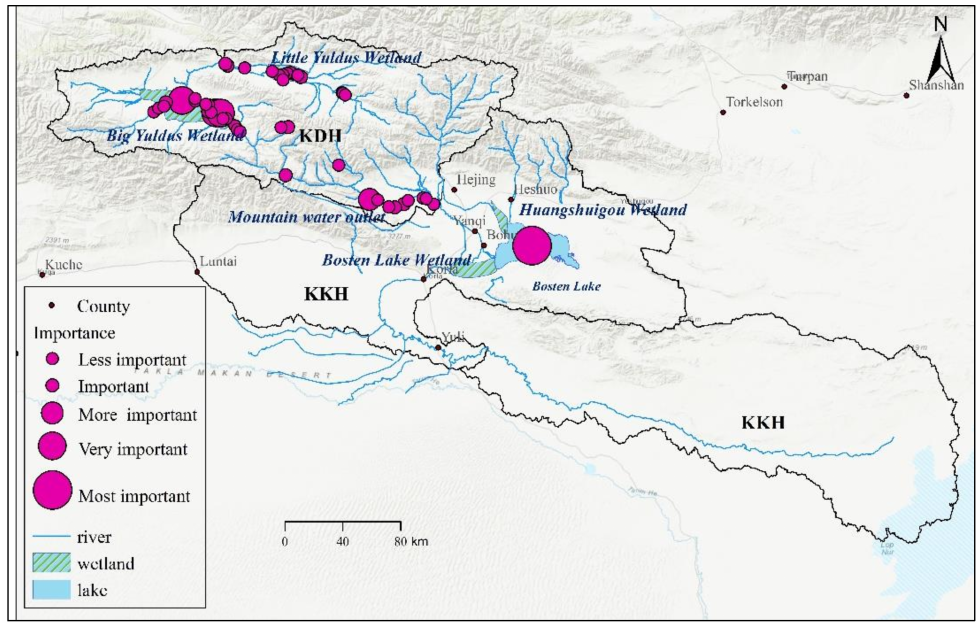
Figure 5. Distribution of key hydrological connectivity nodes in